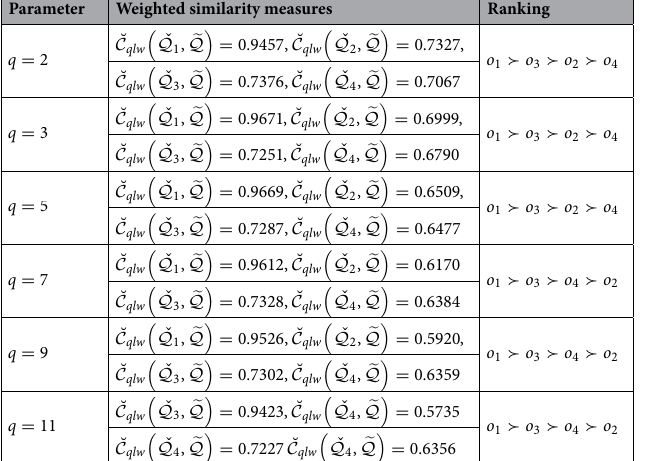
Parameter Weighted similarity